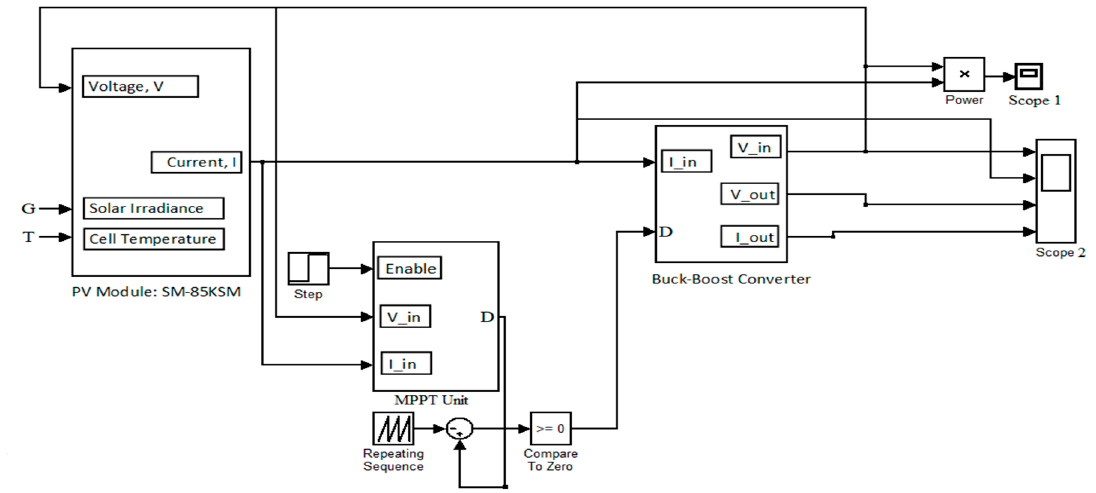
Figure 9. Proposed MPPT solar charge controller in MATLAB/SIMULINK.